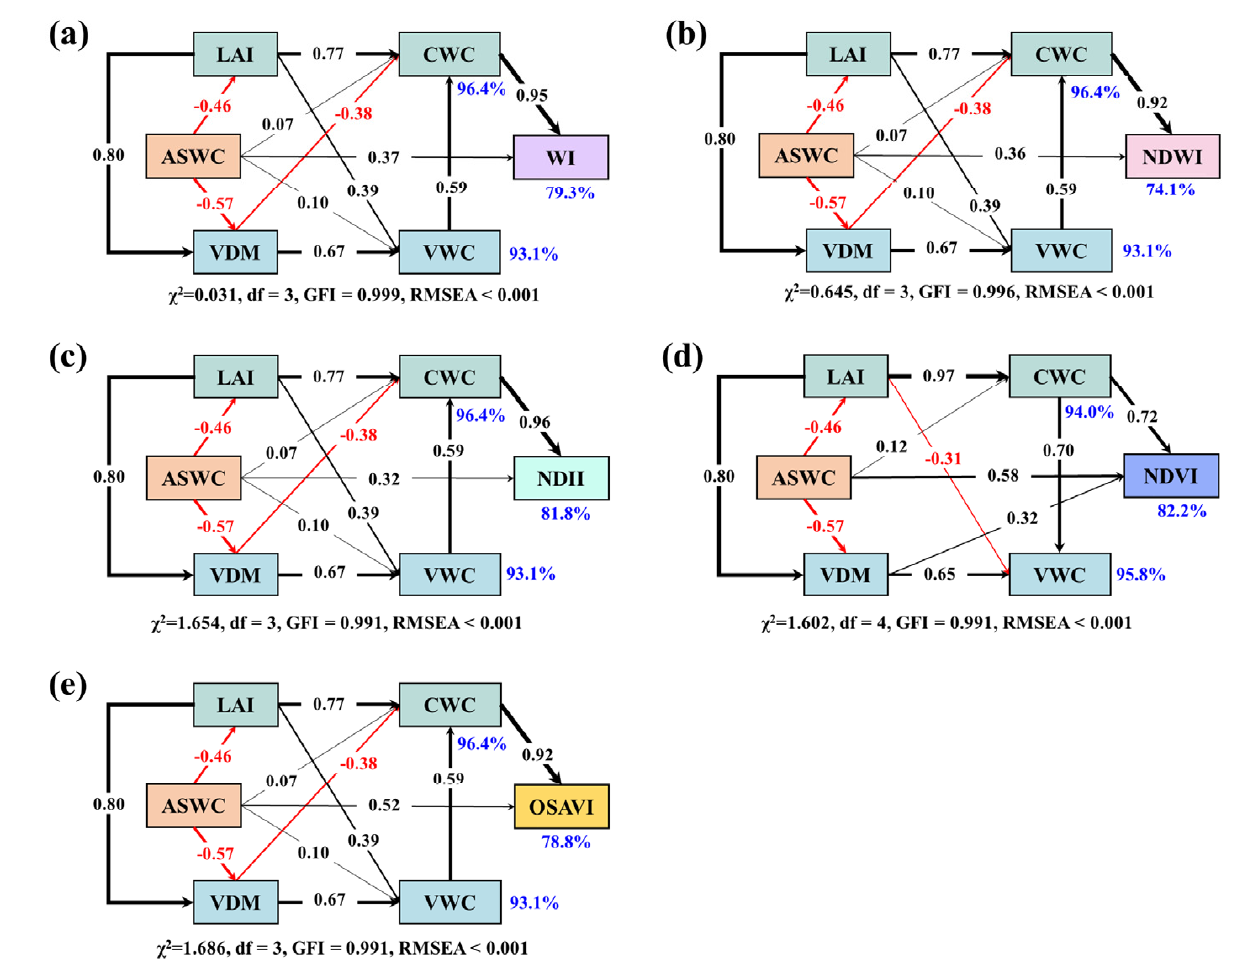
Figure 7. Pathways for abiotic and biotic factors influencing spectral vegetation index during soil drying in the growing season. Structural equation model (SEM) analyses were conducted for five spectral vegetation indices: ( a ) WI, ( b ) NDWI, ( c ) NDII, ( d ) NDVI, and ( e ) OSAVI. Numbers on arrows are standardized path coefficients, and black or red arrows indicate positive or negative relationships between variables, respectively. Goodness-of-fit statistics for the models are shown below the model. ASWC, available soil water content; LAI, leaf area index; CWC, canopy water content; VDM, vegetation dry mass; VWC, vegetation water content in all leaves and stems; WI, water index; NDWI, normalized difference water index; NDII, normalized difference infrared index; NDVI, normalized difference vegetation index; and OSAVI, optimal soil-adjusted vegetation index. χ 2 , chi-squared; df, degree of freedom; GFI, goodness-of-fit index; RMSEA, root mean square error of approximation.